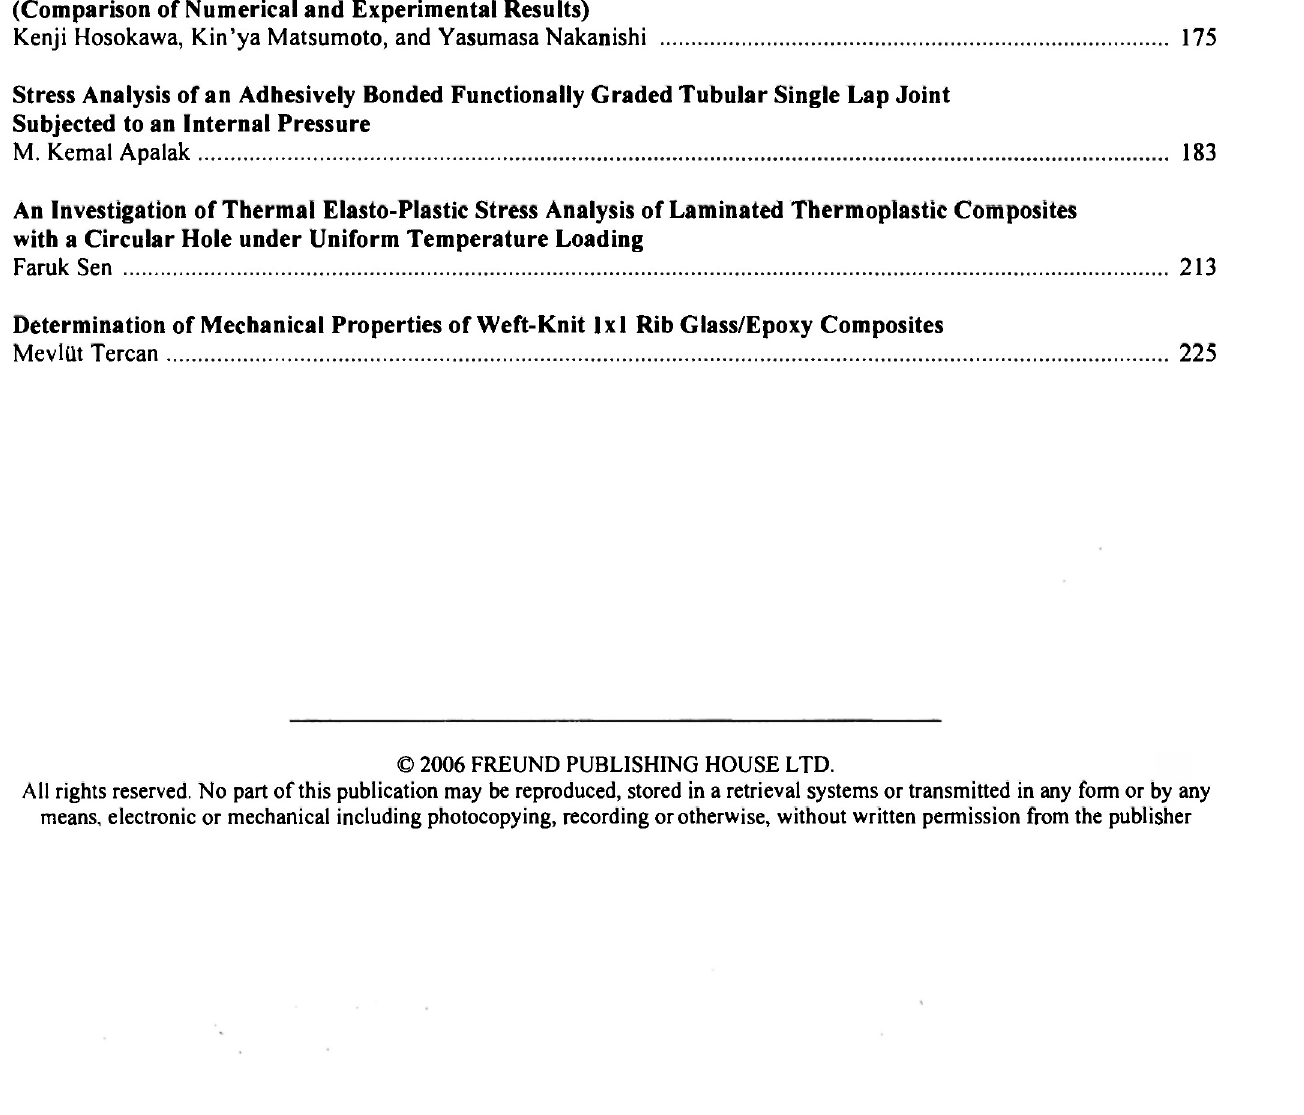
(Comparison of Numerical and Experimental